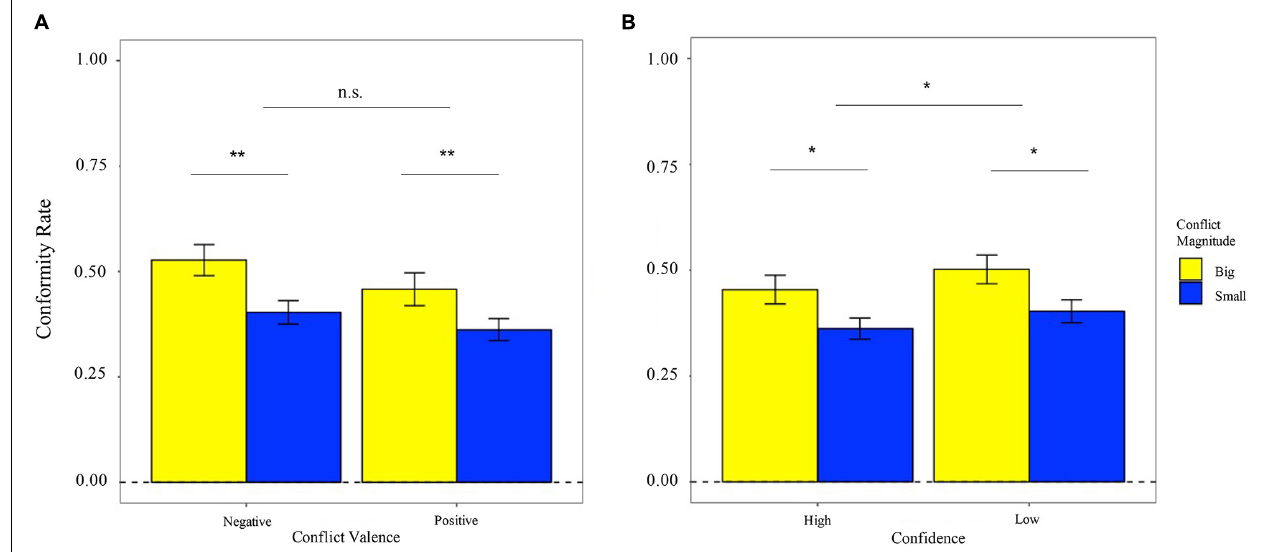
FIGURE 3 | (A) Effects of conflict valence (negative vs. positive) × conflict magnitude (small vs. big) on conformity rate. (B) Effects of confidence (low vs. high) × conflict magnitude (small vs. big) on the conformity rate. ** p < 0.01, * p <